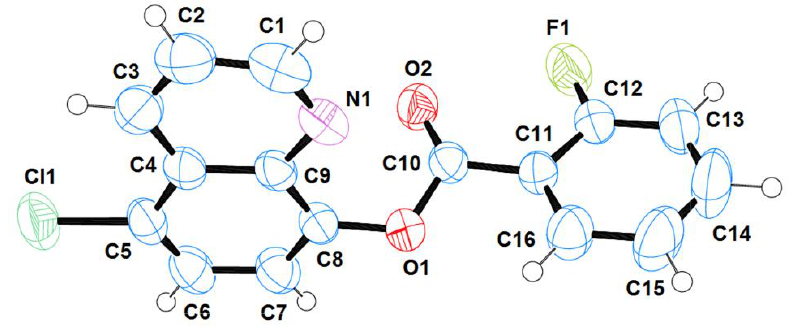
Figure 1. Oak Ridge Thermal Ellipsoid Plot (ORTEP) drawing of the asymmetric unit for compound 3 ; ellipsoids are displayed at the 50% probability level.